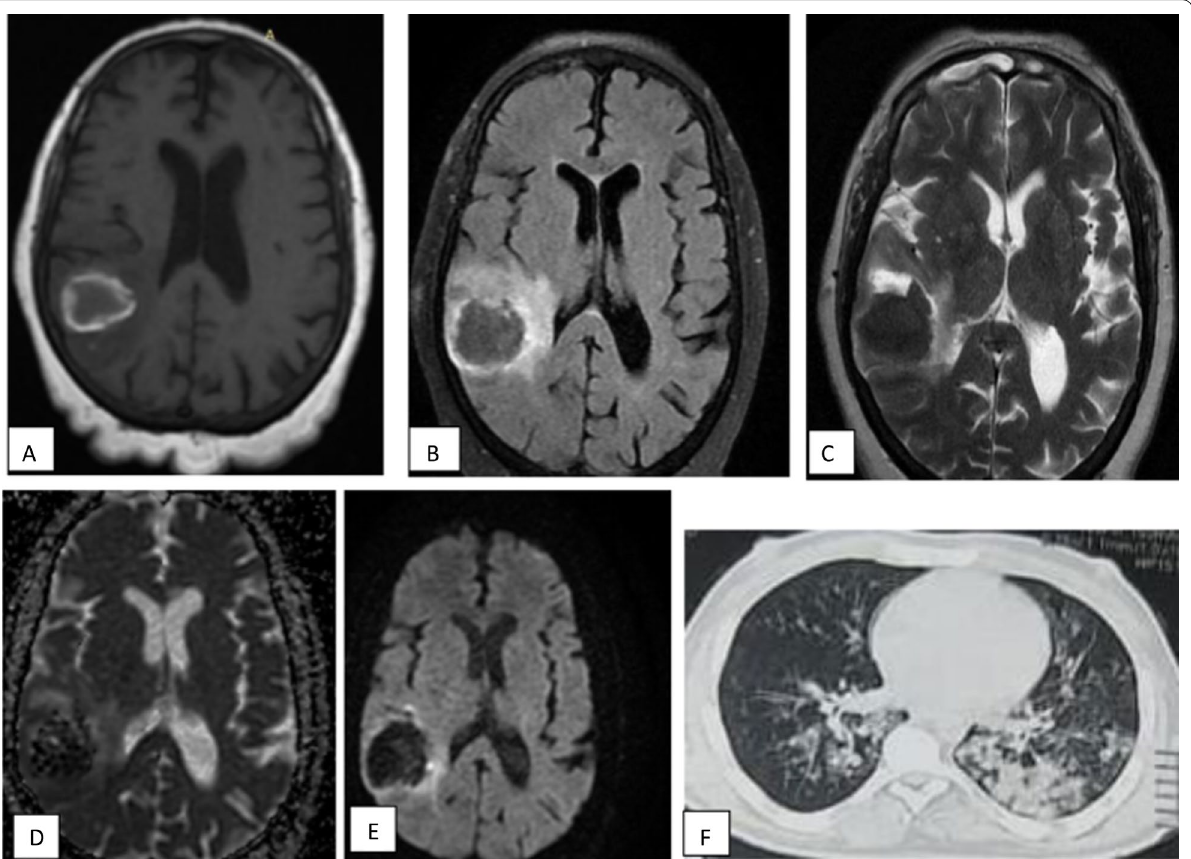
Fig. 4 A 50-year-old male presented with sever continuous headache during COVID infection, expressive aphasia. MRI revealed right occipital well defined intra axial space occupying lesion. a Axial T1 WI showed area of peripheral high SI with central area of iso intense signal intensity. b Axial FLAIR show area of peripheral edema ( c ) axial T2WI showed area of relative low SI with peripheral edema ( d ) ADC map and ( e ) DWI show area of peripheral restriction. Finding correlates with subacute intraparenchymal hematoma. f CT lung showed multifocal GGO and consolidation, very typical COVID abnormalities